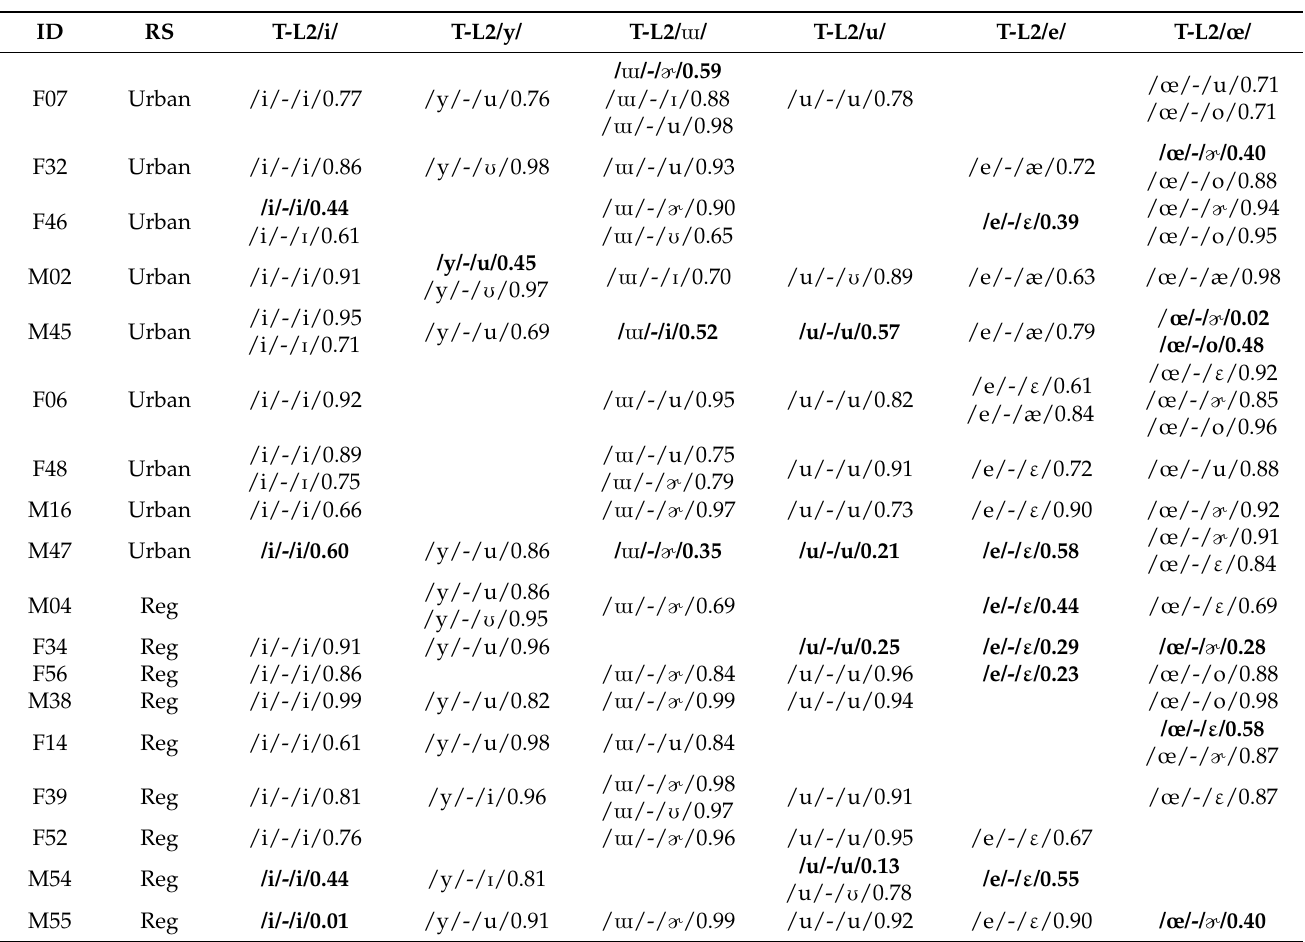
Table 6. Individual Pillai scores for overlapping L2 Turkish–L1 English vowel pairs, presented by speaker ID and residence. The first vowel in the pair corresponds to L2 Turkish vowel, while the second vowel in the pair corresponds to L1 AmE